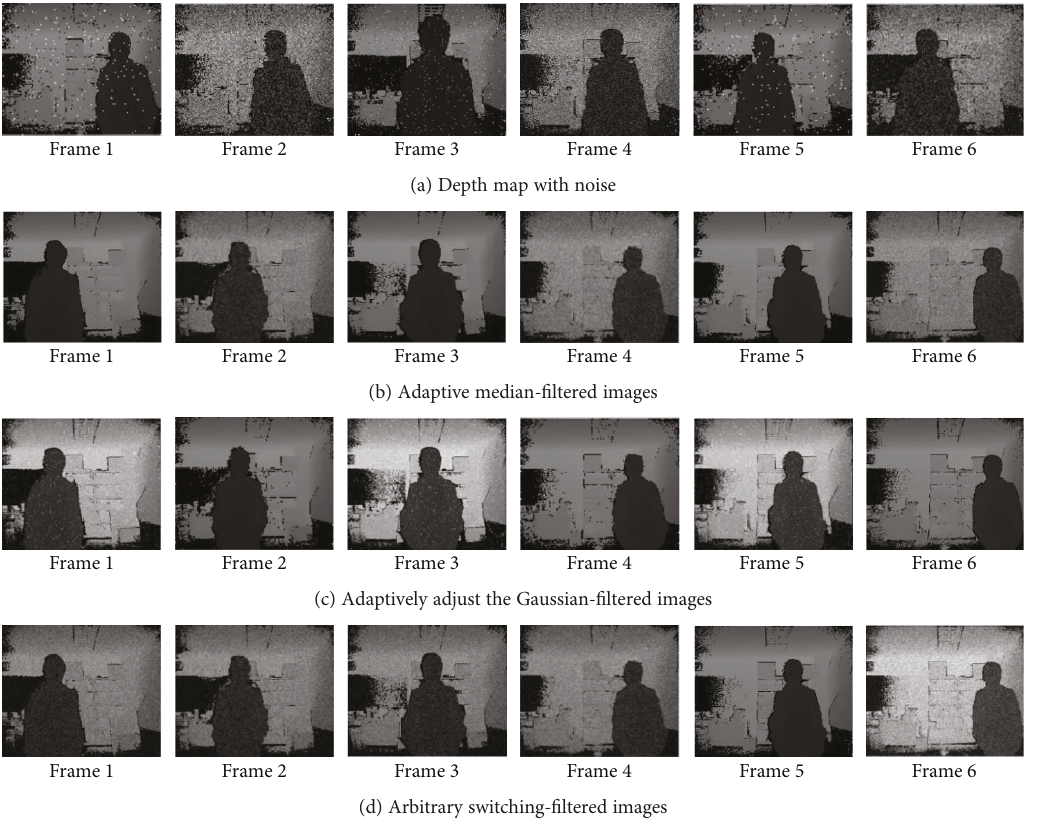
Figure 7: Filter results for the second simulation. Table 1: Peak signal-to-noise ratio for each image after the fi rst test. p = 20% and δ = 20 .